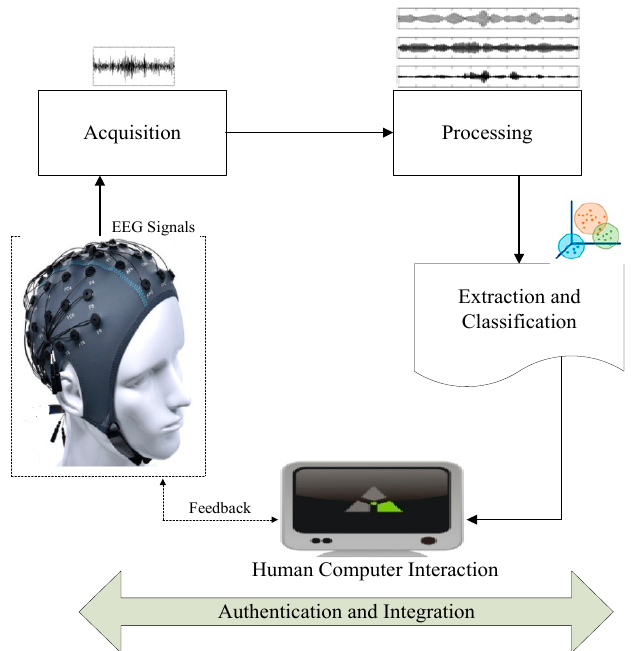
Figure 1. Proposed Cognitive Authentication Framework for smart Healthcare Applications.